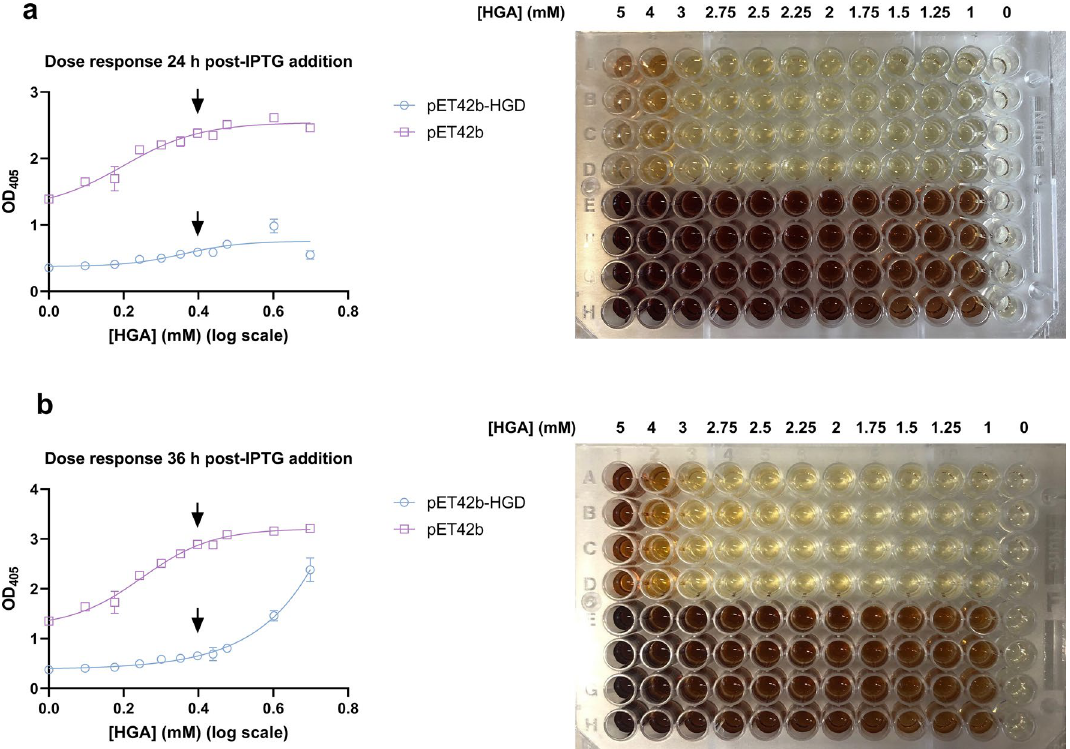
Figure 4. Dose response experiment. E. coli BL21 (DE3) cells containing pET42b-HGD plasmid and the EV control were pre-grown and protein expression was induced as described in the Materials and Methods section. Both cultures were supplemented with different HGA concentrations ranging from 0 to 5 mM. After 24 h ( a ) and 36 h ( b ) post-IPTG addition, OD 405 was measured. An ideal separation window between high and low control signals could be observed when a substrate concentration of 2.5 mM HGA was